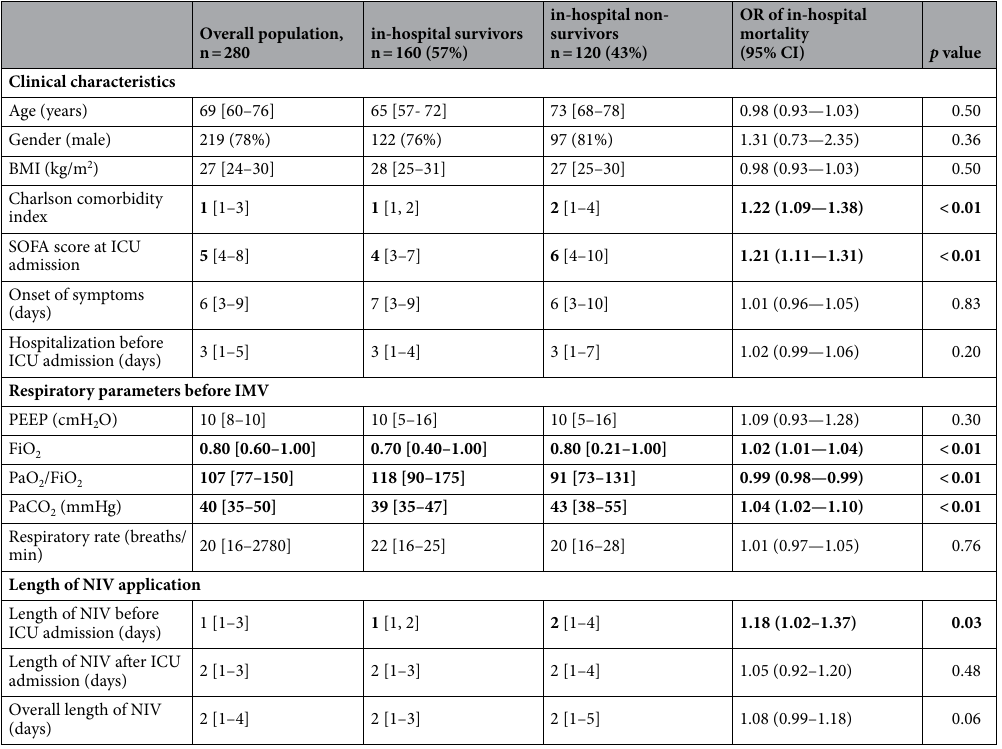
Table 1. Description of clinical characteristics and respiratory parameters based on in-hospital mortality. Data are expressed as median and InterQuartile Range [IQR] or number (%), Odds Ratios (OR) and 95% Confidence Interval (CI). Bold values are statistically significant. BMI: body mass index; SOFA: sequential organ failure assessment; ICU: intensive care unit; PEEP: positive end-expiratory pressure; PaO 2 /FiO 2 : ratio between partial pressure of arterial oxygen and fraction of inspired oxygen; PaCO 2 : partial pressure of carbon dioxide; NIV: non-invasive ventilation; IMV: invasive mechanical ventilation.